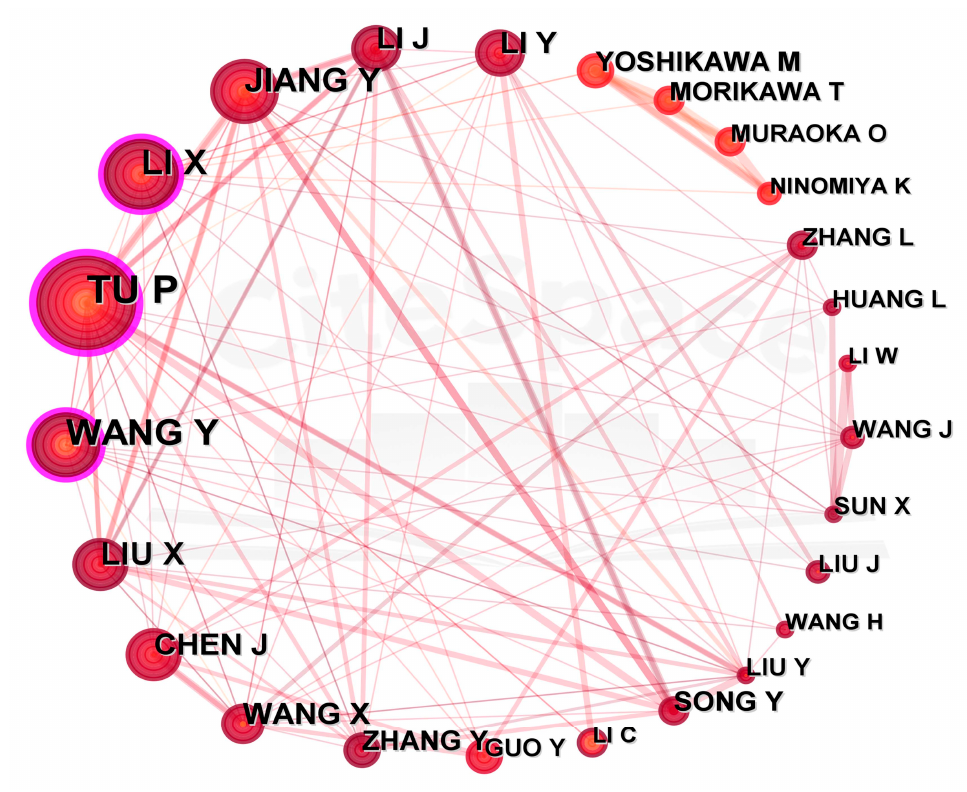
Figure 5. Top 25 authors in Cistanche -related study (1980–2022). Node size represents the number of publications. Purple circles indicate that these authors made significant contributions to the study. The diameter of lines represents the degree of cooperation.